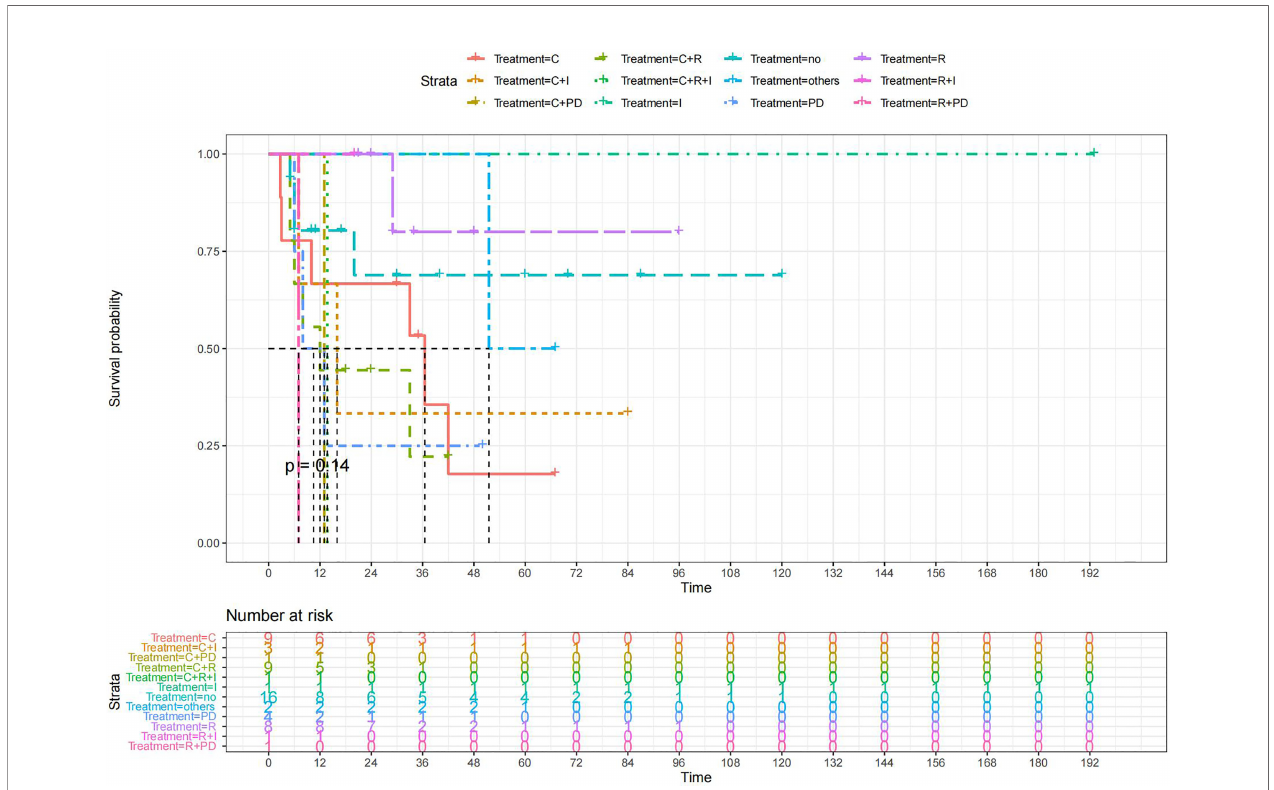
FIGURE 10 | Kaplan-Meier survival curves for OS in patients of RH-based surgery plus various treatments vs. no other treatments. The median OS was signi fi cantly longer for patients who added chemotherapy and other treatments(oncolytic virus Rigvir ® , argon laser, Argon heliumknife) than for those who added the remaining treatment modalities (Except for radiotherapy and no other treatment added, Survival rates of these two group at the 48m time point were signi fi cantly higher for patients than others.) C:chemotherapy R:radiotherapy I:immunotherapy(interferon- g or interleukin-2) PD : PD-1/PD-L1 Others:oncolytic virus Rigvir ® , argon laser, Argon heliumknife+Sunitinib no:no other treatment.